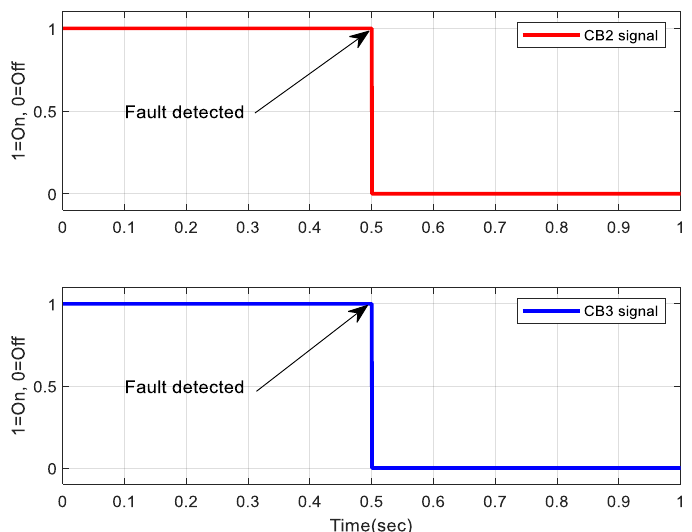
Figure 8. The CB2 and CB3 signals under grid fault occurrence at Line-1.